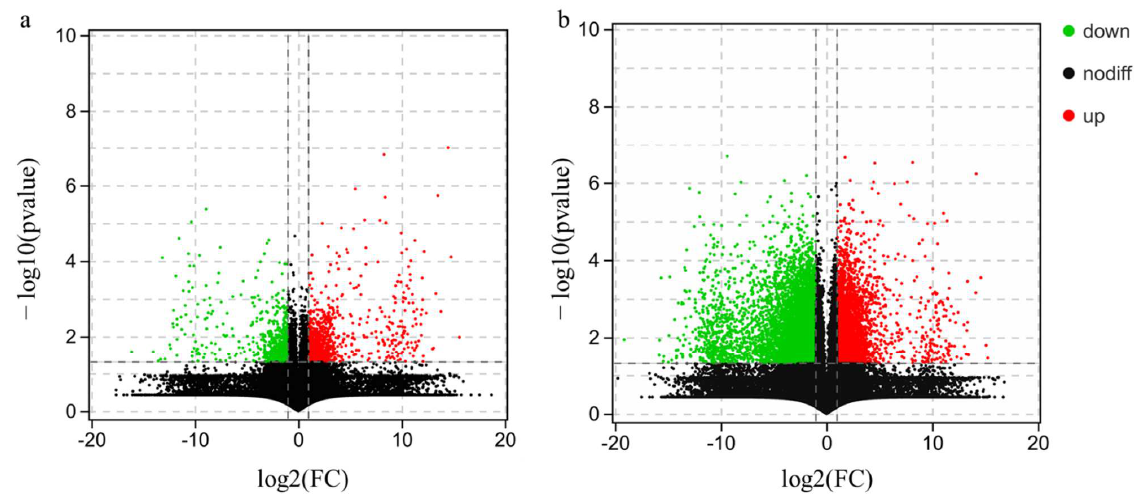
Figure 3. The volcano map of differentially expressed genes for different treatments ( a ) and different parts of the fruiting body ( b ).